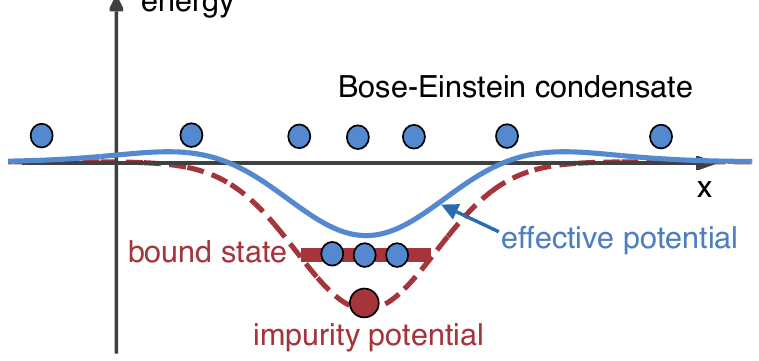
Figure 1: Illustration of the self-stabilized Bose polaron. The strong-coupling Bose polaron mimics a microtrap (red dashed line) with bound state (red bar) within the Bose-Einstein condensate. If several bosons (blue dots) occupy the bound state, bo- son repulsion results in a shallower effective potential seen by the remaining bosons (blue solid line) that no longer admits a bound state. The dressing cloud itself thus stabilizes the Bose